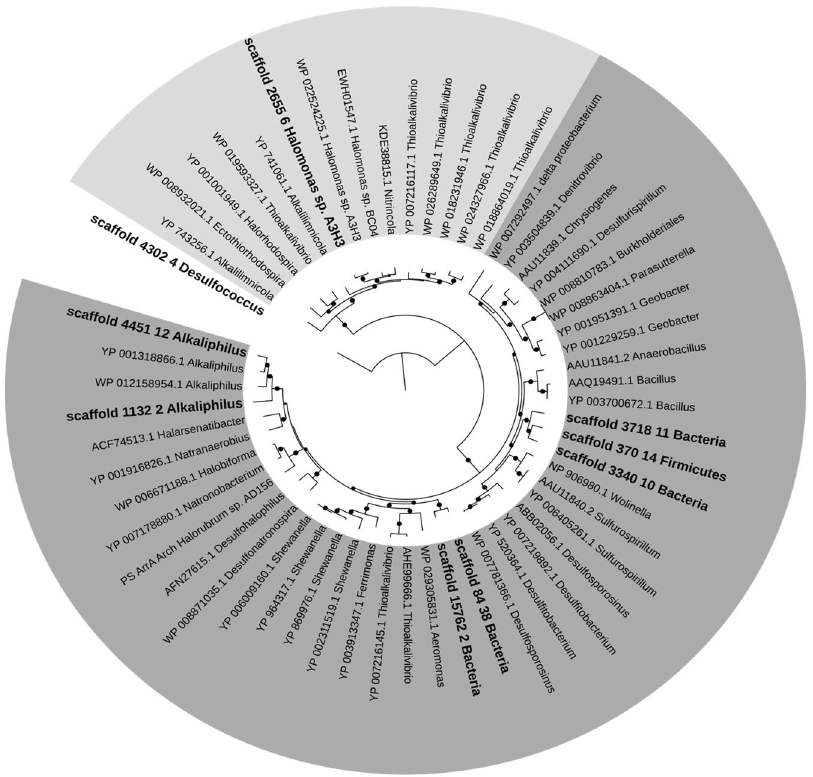
Figure 6. ArrA subfamily maximum likelihood tree. The arsenite oxidases clade ArxA is shown in light grey and the arsenate reductases in dark grey. The tree is rooted with scaffold_4302_4, which belongs to another DMSO reductases subfamily. Socompa sequences are in bold. Nodes with bootstraps above 0.7 are marked with a filled